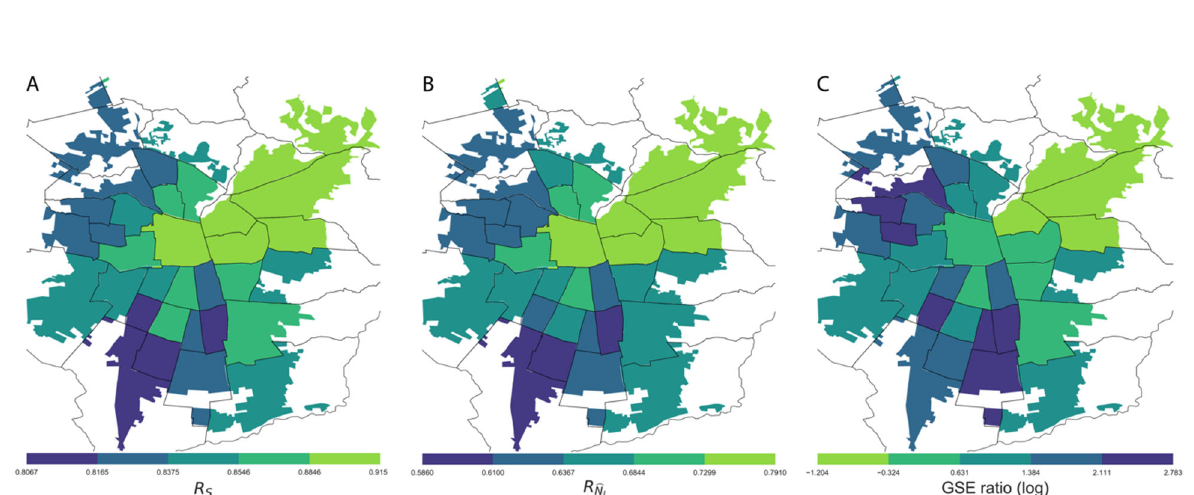
GSE are ranked from the highest (ABC1) to the lowest (E). For each metric X , the effect size Δ is measured as Δ X = 〈 X 〉 M − 〈 X 〉 F . Square brackets report 95%